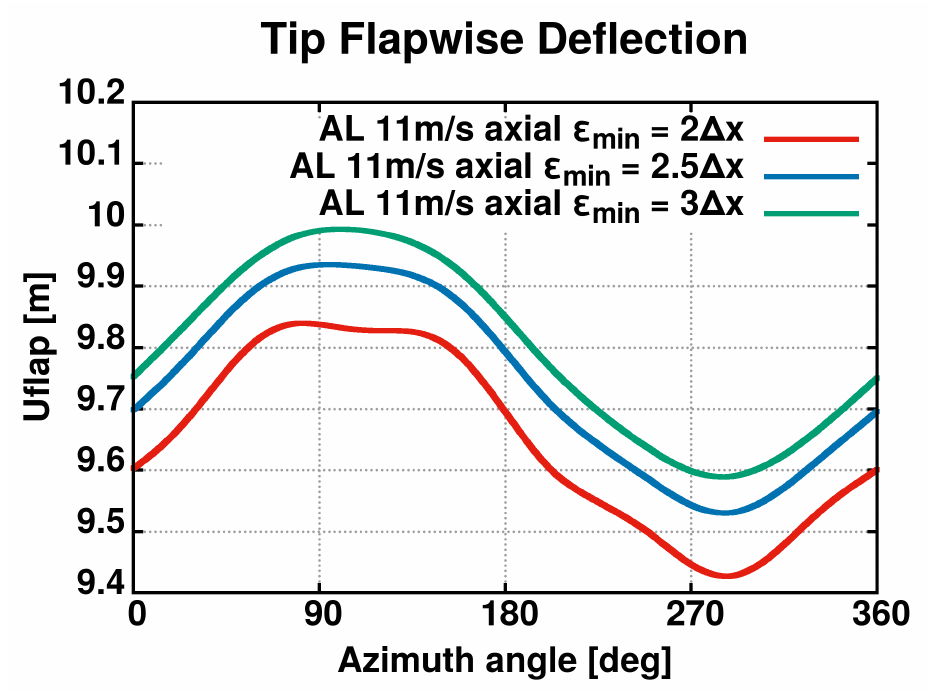
Figure 13. Minimum value of (cid:101) investigation. Flapwise deflection in axial uniform free-stream flow at 11